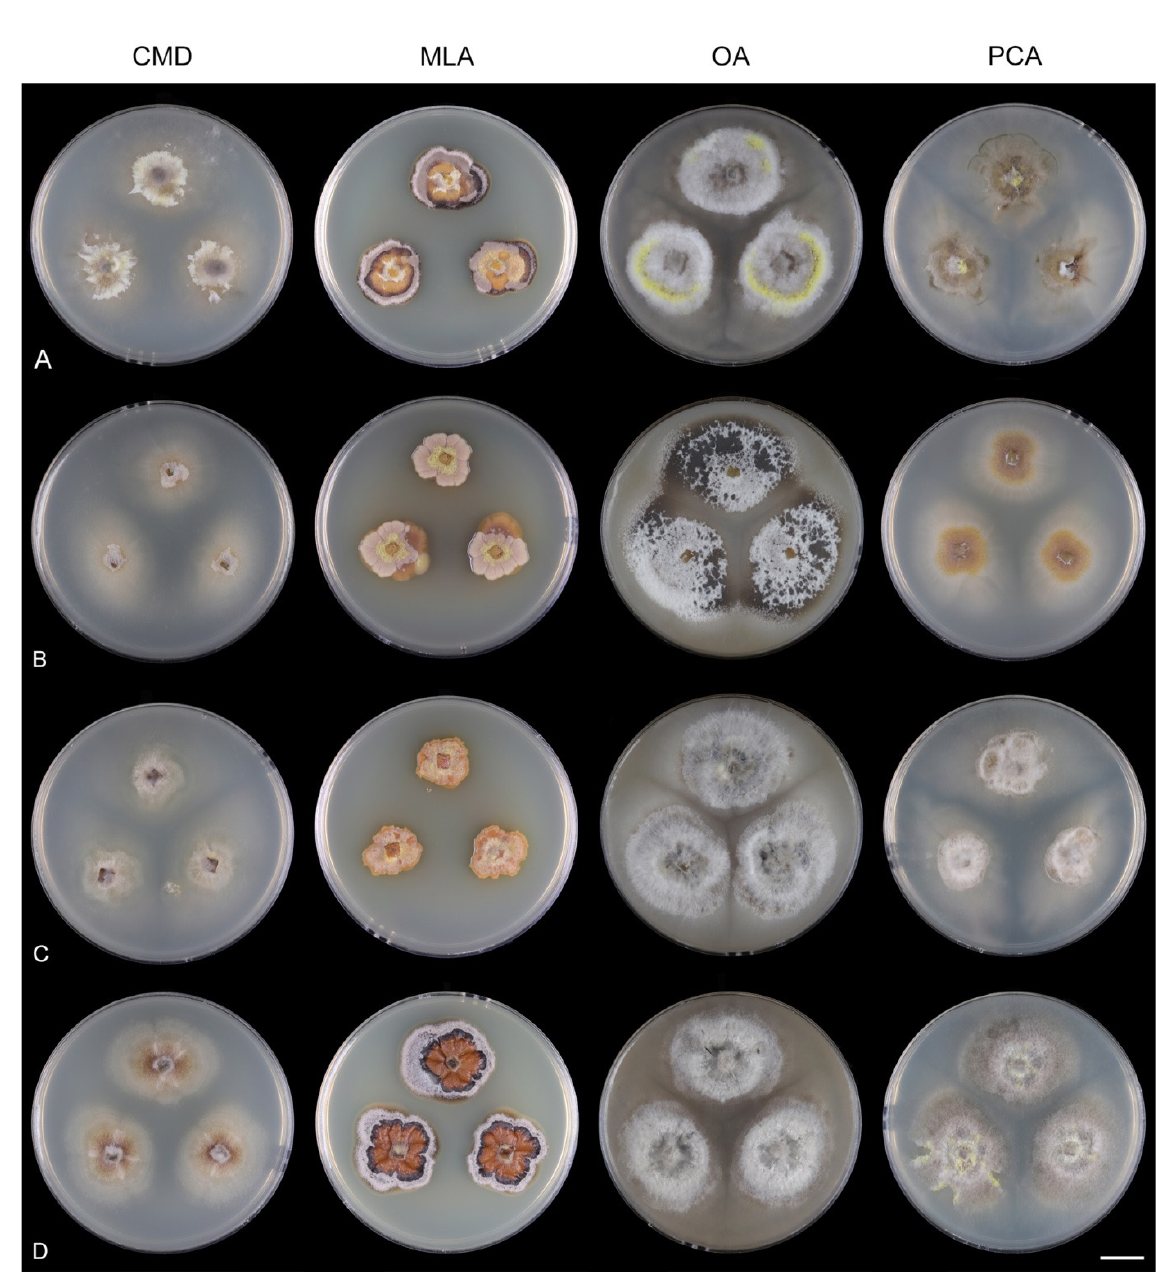
Figure 25. Colony morphology of Codinaeella lutea after 4 weeks. ( A ) CBS 146618 ex-type ( B ) CBS 624.77 ( C ) ICMP 14613 ( D ) ICMP 15544. Scale bar: ( A – D ) 1 cm.